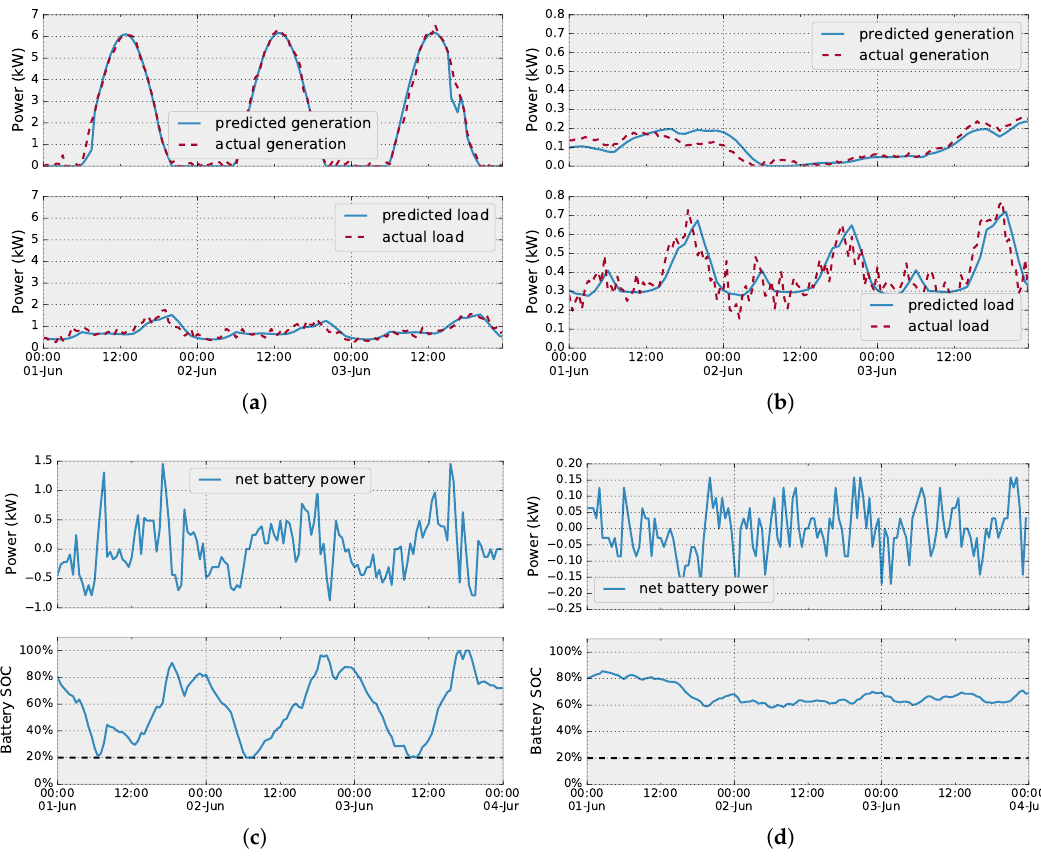
Figure 5. Input and output profiles for two sample users: ( a ) PV generation and load profiles for User B; ( b ) wind turbine generation and load profiles for User C; and battery power and SOC profiles for User B ( c ) and C ( d